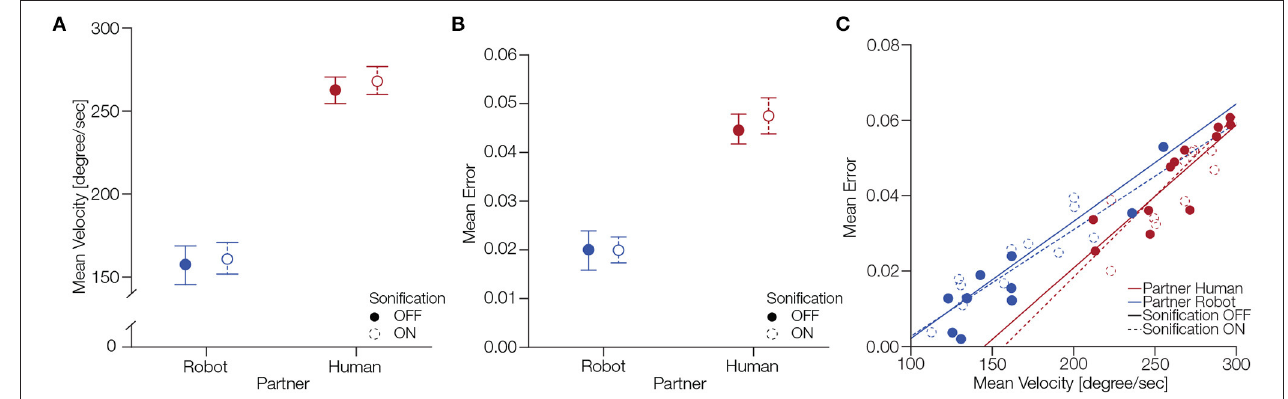
FIGURE 4 | Behavioral differences between conditions partner and sonification. (A) Differences in mean angular velocity across different participants. The error bars indicate standard error of mean. (B) Differences in mean error across different participants. The error bars indicate standard error of mean. Panel (C) shows the correlation of mean error and mean velocity for partner and sonification